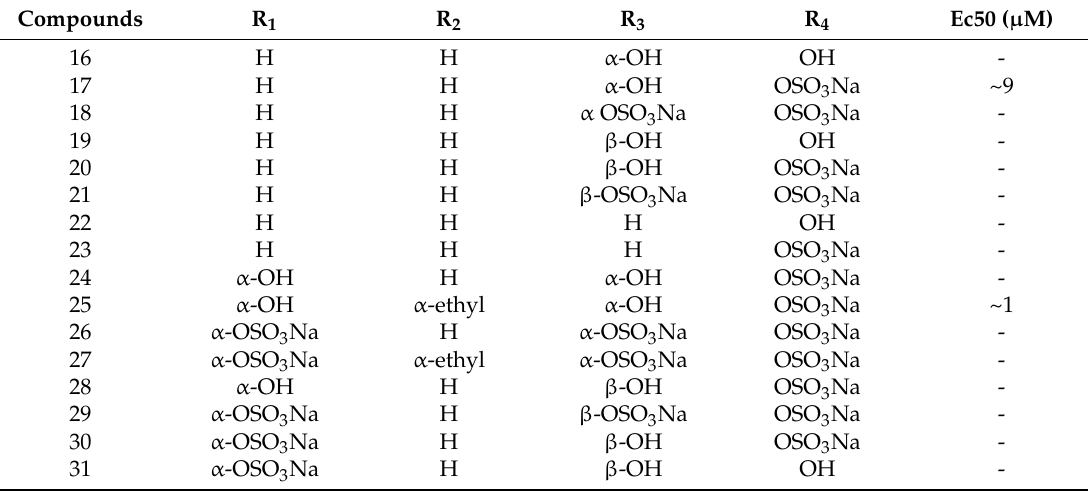
Figure 3. 2D image of the changes to bile acids sca ff old reported in Table 2. Table 2. Modifications made on bile acids sca ff